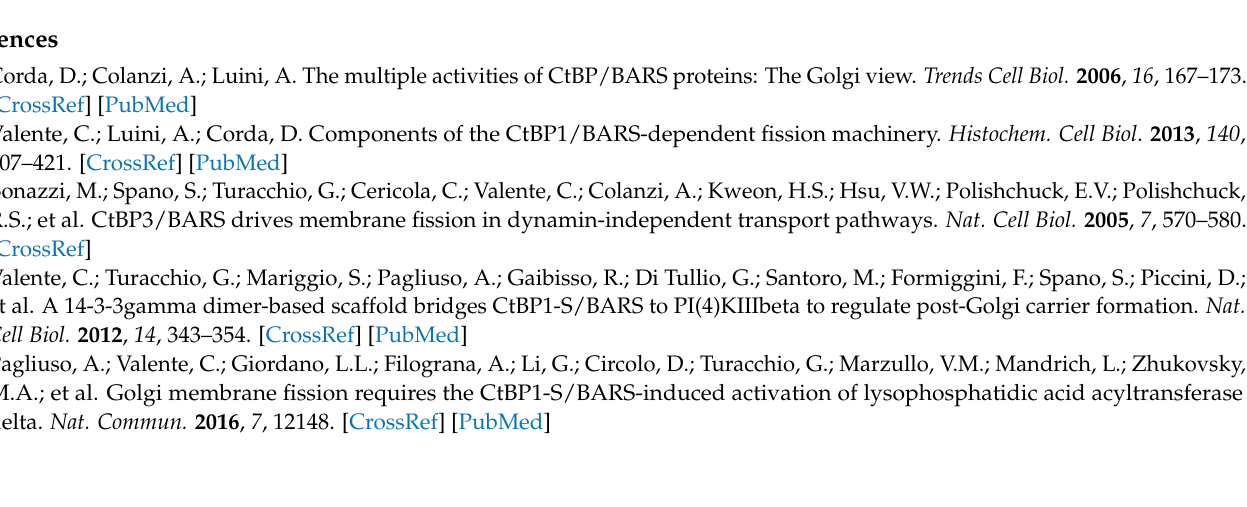
reduces BARS expression in cultured cells. Figure S2: Schematic representation of BARS domain structure and BARS mutant cDNA constructs used in this paper. Figure S3: BARS do not regulate proliferation, differentiation and centrosome orientation in cortical neurons. Figure S4: Regulated secretion/aggregation FM-based system. Figure S5: Distribution of ApoER2-GFP in cultured neurons. Figure S6: BARS regulates trafficking of L1. Figure S7: BARS does not regulate trafficking of